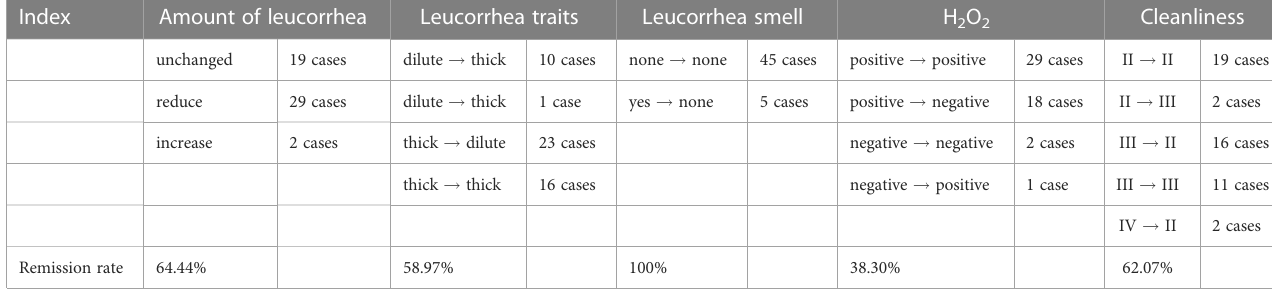
TABLE 2 Changes in vaginal secretion properties and biochemical parameters after the use of postbiotic gel.